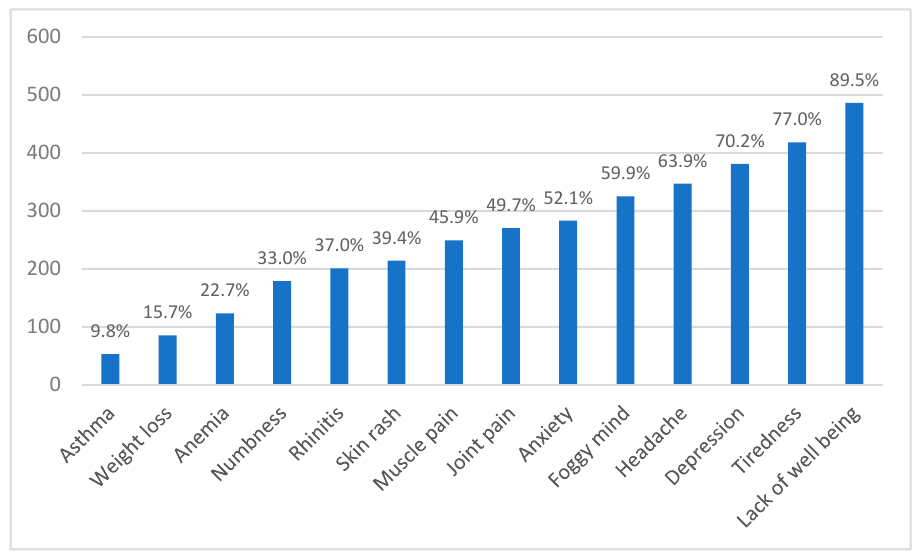
Figure 2. Gastrointestinal symptoms in Brazilian NCGS subjects (N = 543).